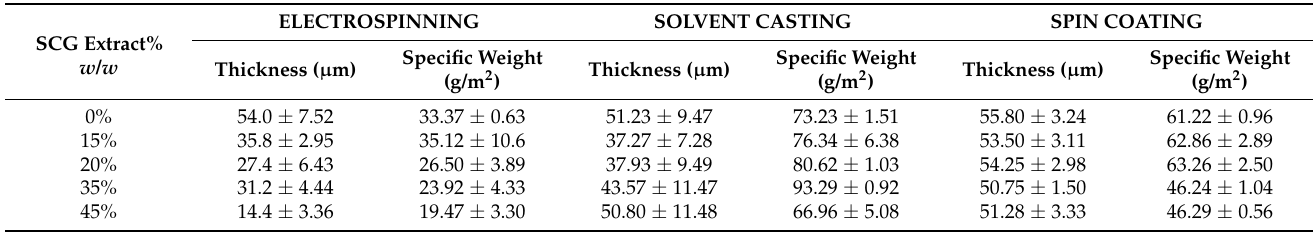
Table 1. Thickness and specific weight of the zein samples produced by electrospinning, solvent casting, and spin coating by varying the SCG extract concentration.